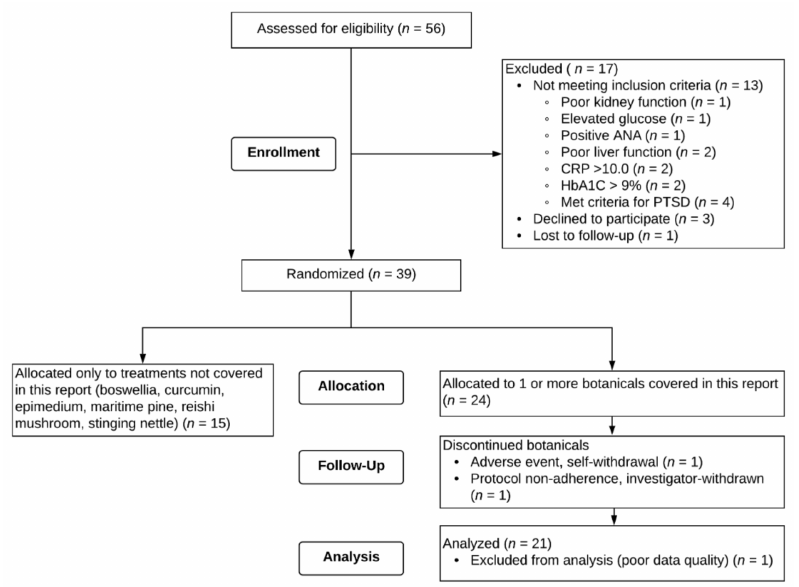
Figure 2. CONSORT Flow diagram. Twenty-four individuals were randomized to at least one of the treatments covered in this